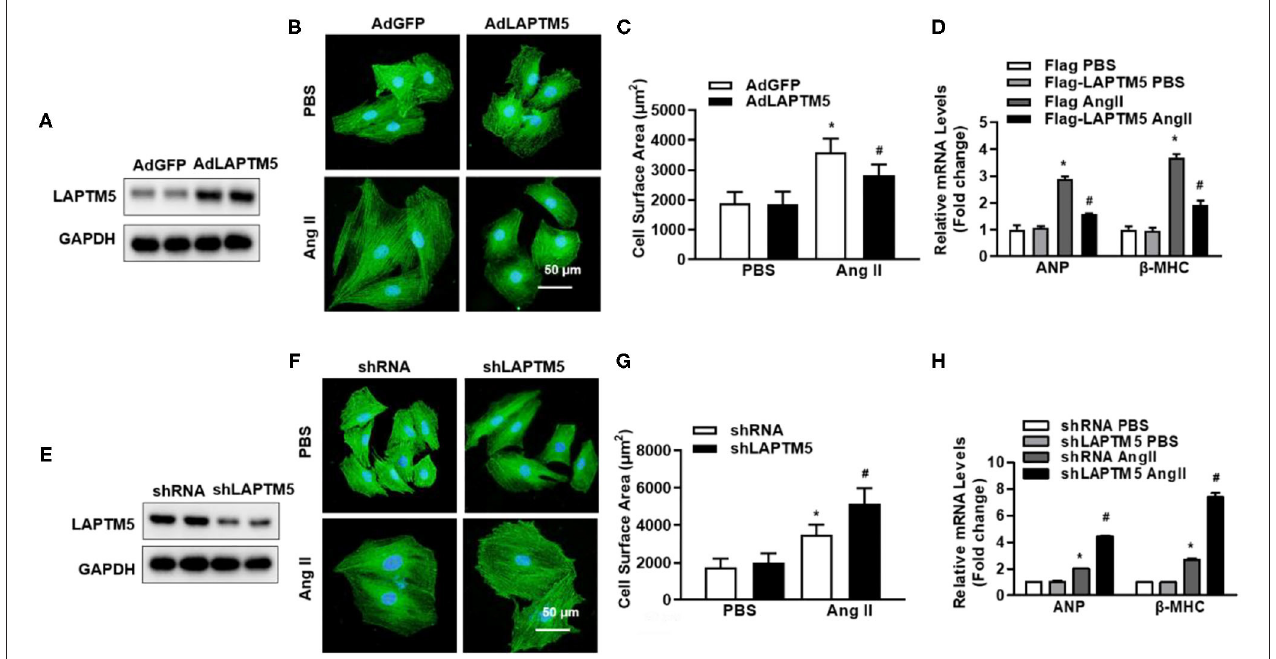
FIGURE 2 | LAPTM5 alleviates cardiomyocyte hypertrophy in vitro induced by Ang II. (A) Western blot analysis of LAPTM5 expression. (B) Representative images of cardiomyocytes infected with the indicated adenoviruses and then treated with PBS or Ang II for 48h. (C) Quantitative results for the cell surface area of NRCMs infected with AdLAPTM5 or AdGFP (control) and treated with PBS or Ang II for 48h. (D) The mRNA levels of ANP and β -MHC in each group (* P < 0.05 vs. AdGFP PBS, # P < 0.05 vs. AdGFP Ang II). (E) The protein levels of LAPTM5 detected by western blot. (F) Representative images of cardiomyocytes in the indicated groups. (G) Quantitative results for the cell surface area in the indicated groups. (H) The mRNA levels of ANP and β -MHC detected by real-time PCR in the indicated groups (* P < 0.05 vs. shRNA PBS, # P < 0.05 vs. shRNA Ang II).